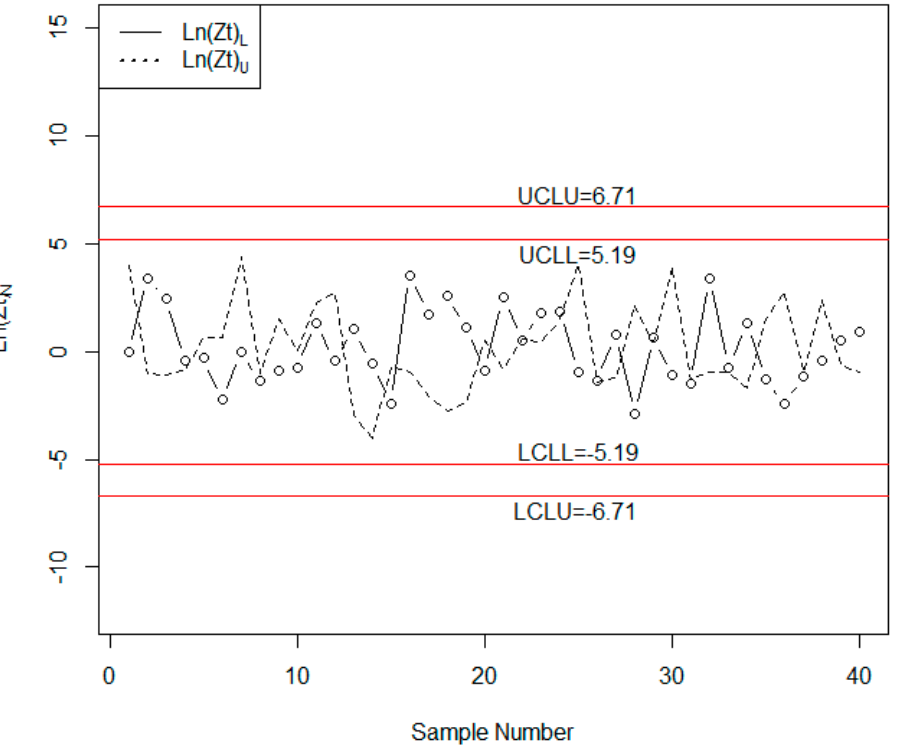
Figure 3. The proposed chart for the real data.